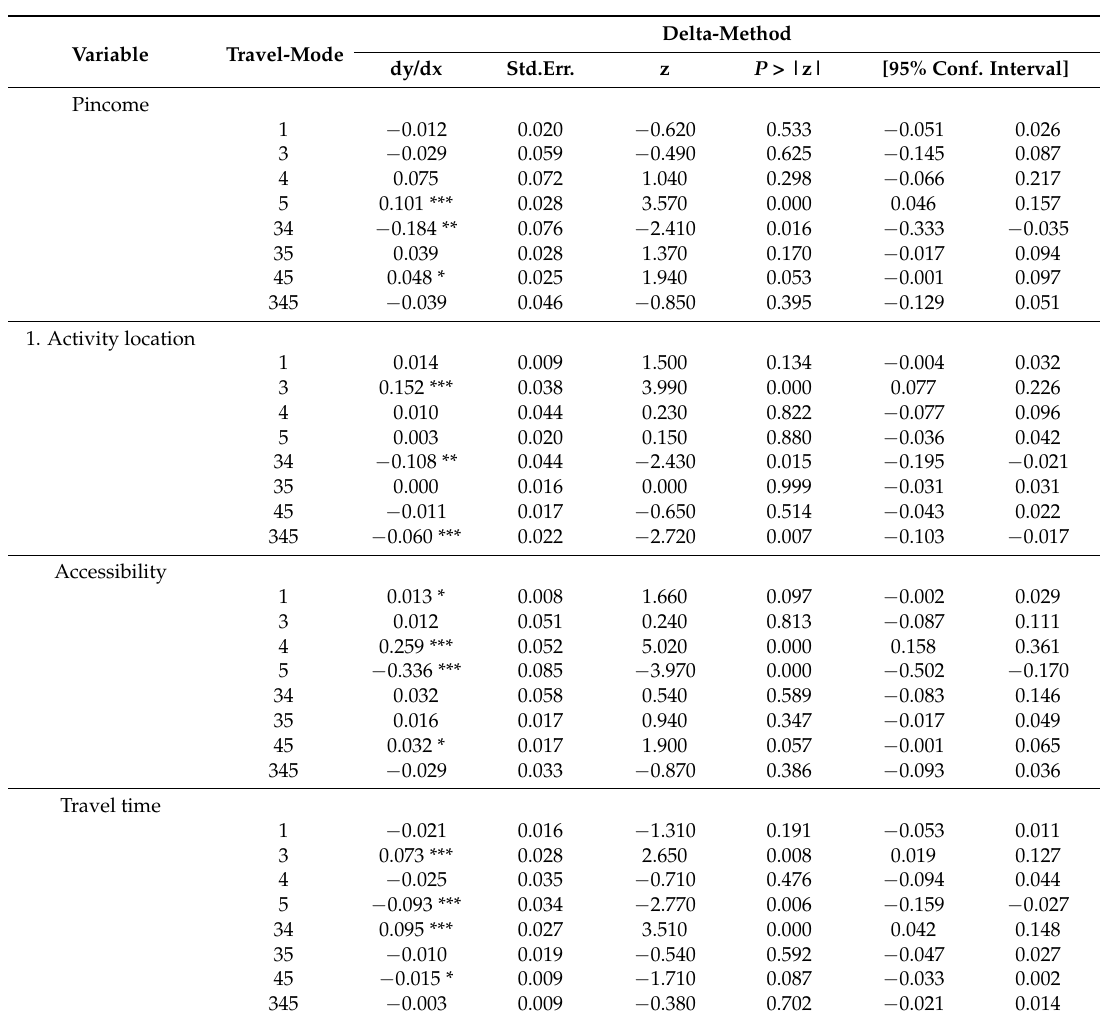
Table 10. Marginal effects of different variables for each travel-mode